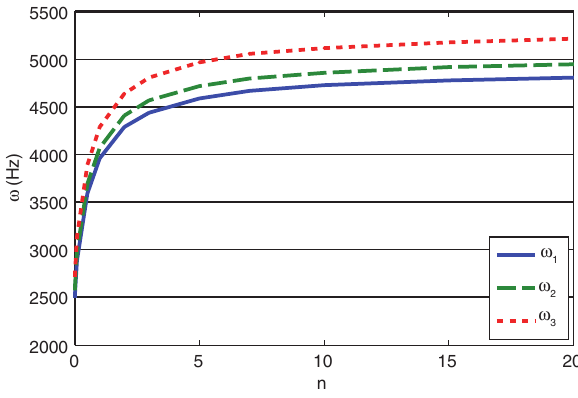
Figure 8 Variation in the first three natural frequencies of an isotropic FG annular sector plate clamped at the radial edges for different power-law exponents and θ = 200 ° .